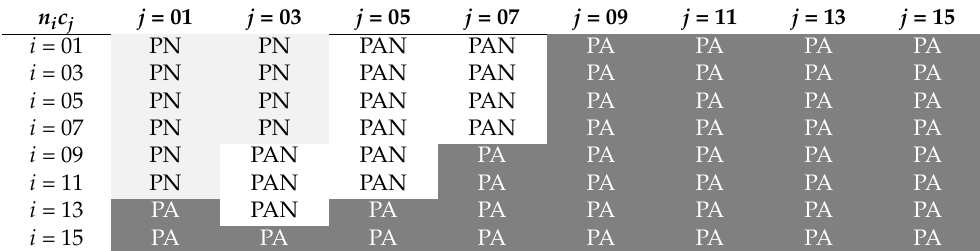
Table 10. Classifications of respondents’ perceived asymmetry (post-revision).